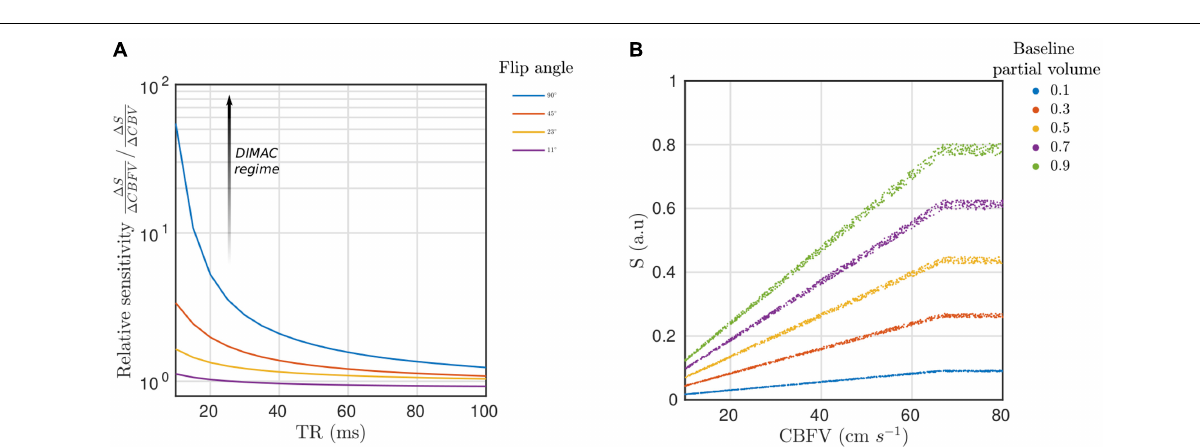
FIGURE 3 | (A) Relative sensitivity of spoiled gradient-recalled-echo (GRE) signal to pulsatile cerebral blood flow velocity (CBFV) compared with pulsatile cerebral blood volume (CBV), where each line represents a different flip angle. The annotated arrow represents how the GRE signal moves into the DIMAC regime of high sensitivity to pulsatile CBFV over pulsatile CBV as TR decreases and flip angle increases. (B) Scatterplot of simulated spoiled GRE signal in the DIMAC regime of low TR (15 ms) and high flip angle (90 ◦ ) as a function of CBFV. Note that the spread of data points reflects signal variance due to pulsatile CBV, which is small compared with variance due to CBFV within the normal physiological range. In every case the signal plateaus at the critical velocity 66 cm s − 1 , i.e., when flow velocity increases to the point when spins only experience a single RF pulse and the signal becomes sensitive to CBV